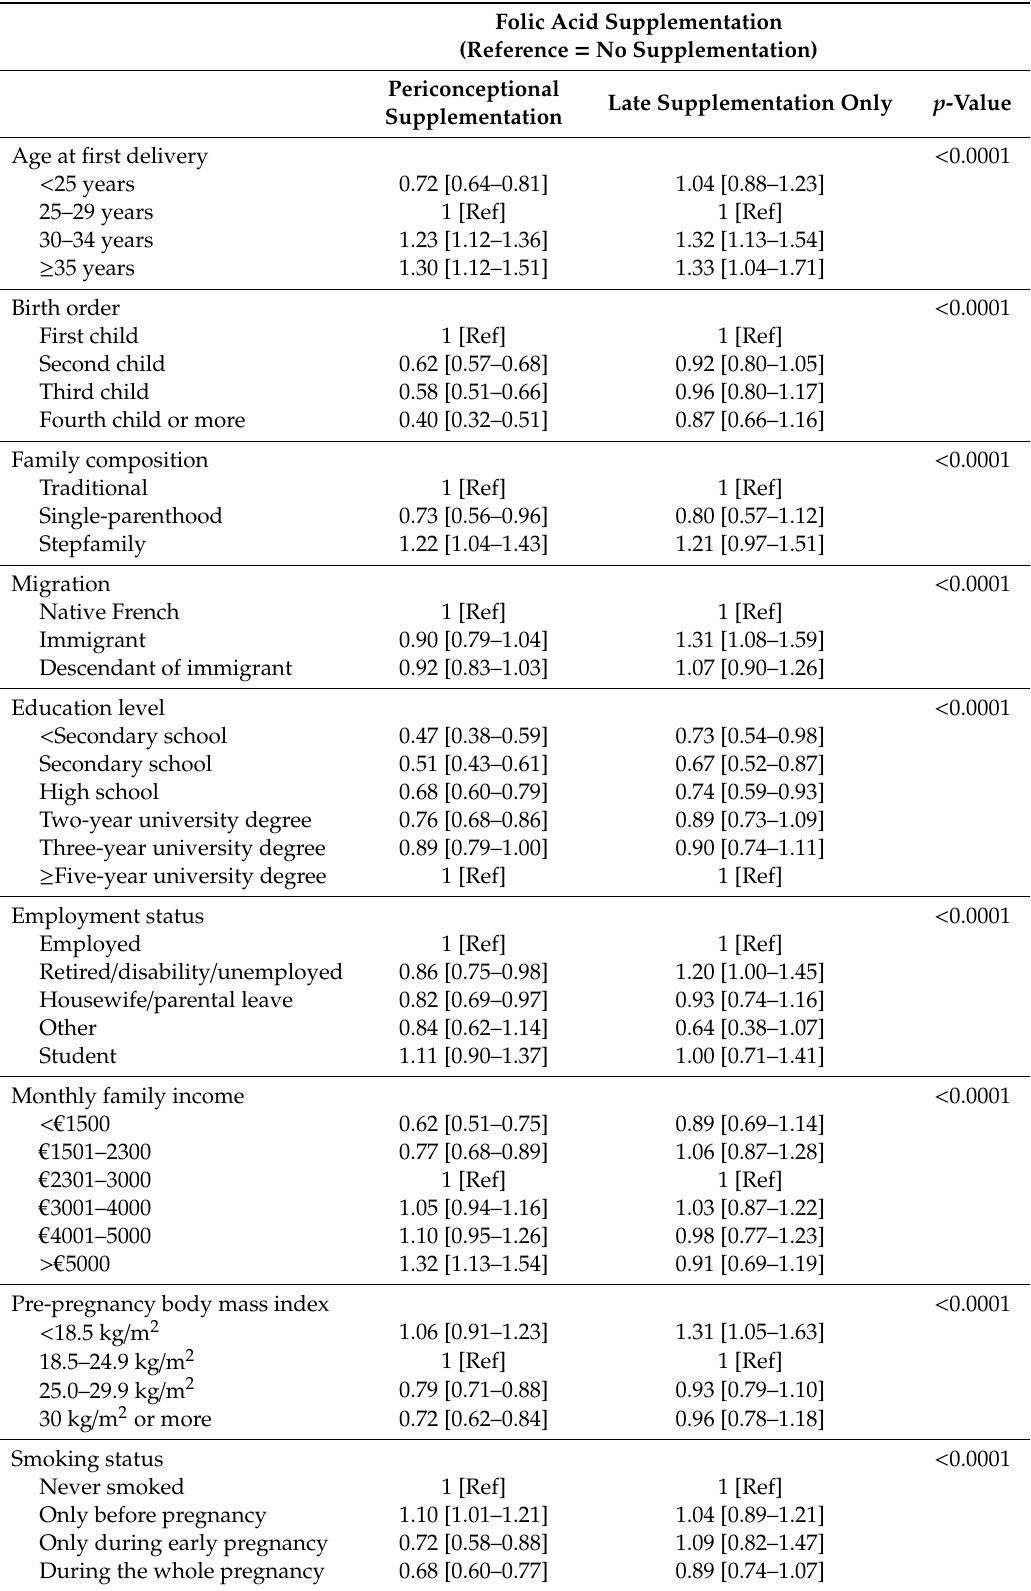
Table 3. Multivariate associations between sociodemographic characteristics and timing of folic acid supplementation ( n =